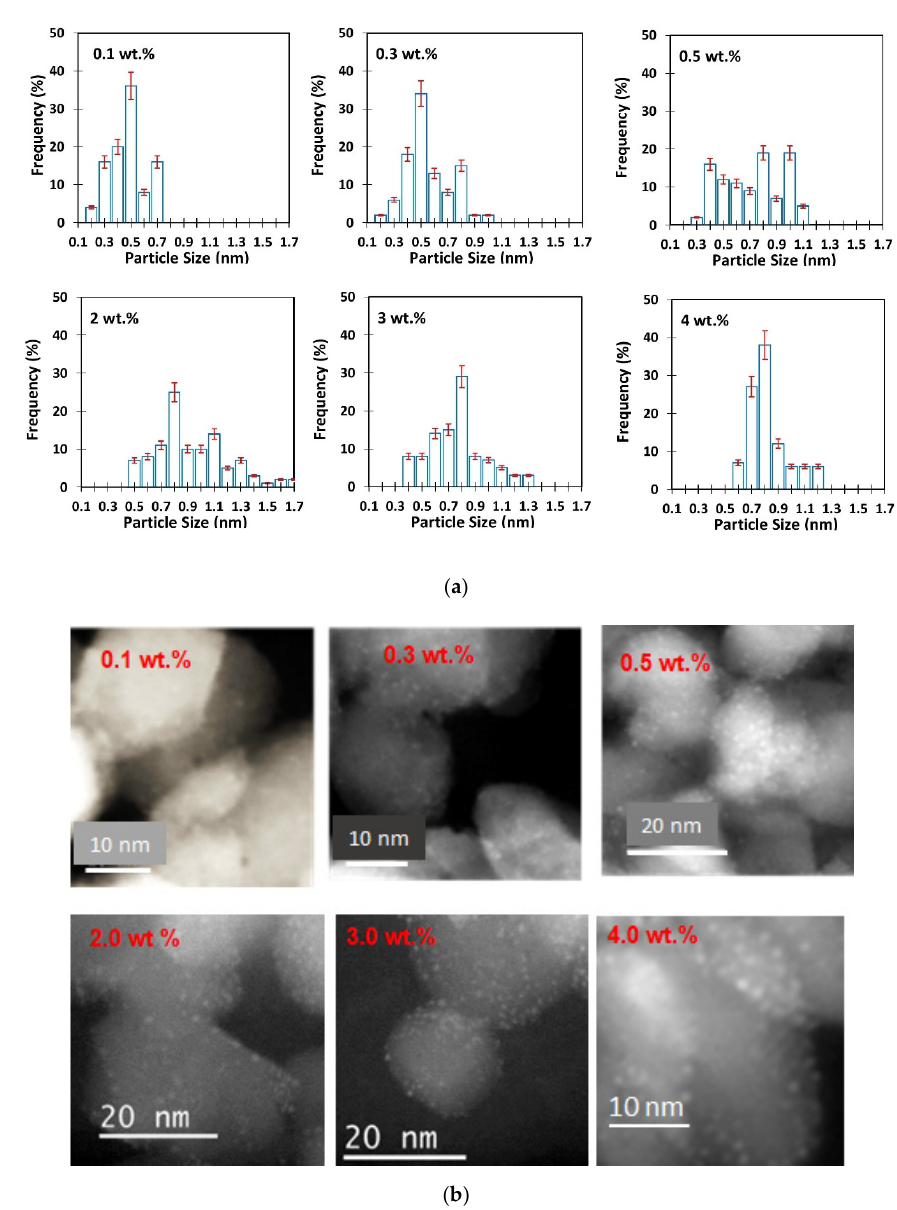
Figure 1. ( a ) IrO 2 particle size distribution from ( b ). ( b ) STEM images of a selected number of IrO 2 /TiO 2 catalysts with the indicated Ir wt. % loading. IrO 2 clusters are shown as white dots on top of the anatase TiO 2 support (grey).